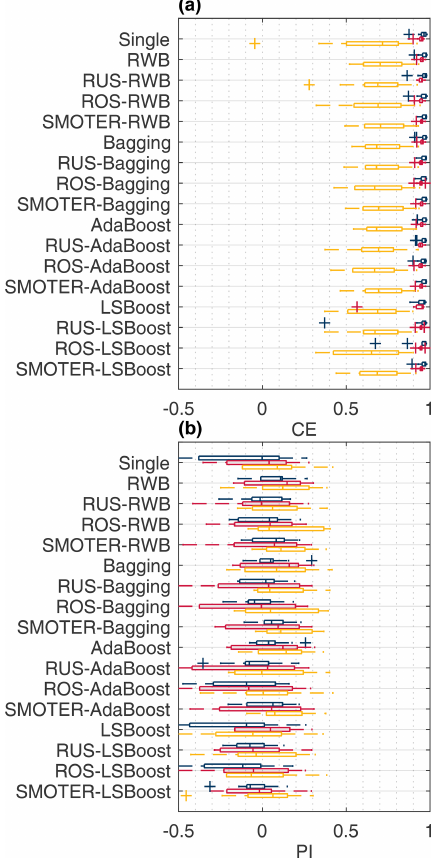
Figure 7. Overall (blue), typical stage (red), and high stage (yellow) CE (a) and PI (b) for the Bow River